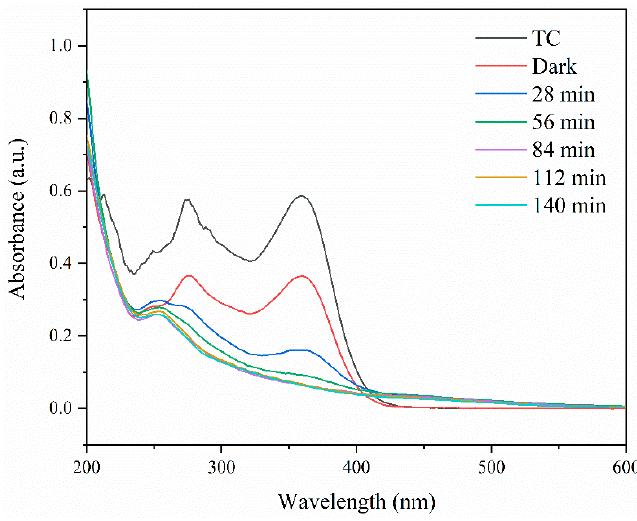
Figure 8. Absorption spectra changes of TC over 0.4Ni/Ti-Bi 2 WO 6 .